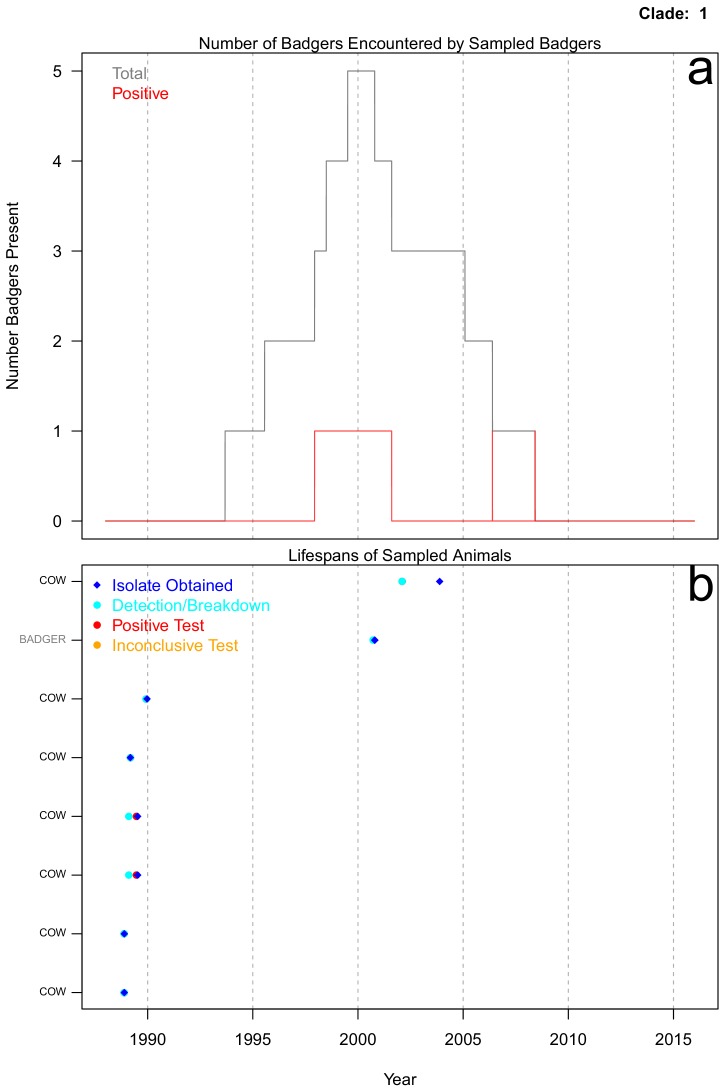
Life history summaries of the sampled and in-contact cattle and badgers associated with clade 1 in Figure 1.(a) The number of in-contact badgers associated with the sampled badgers (total in grey, number of animals that have tested positive in red). (b) The recorded lifespans of the sampled cattle (black horizontal bars) and badgers (grey horizontal bars) associated with clade 1.